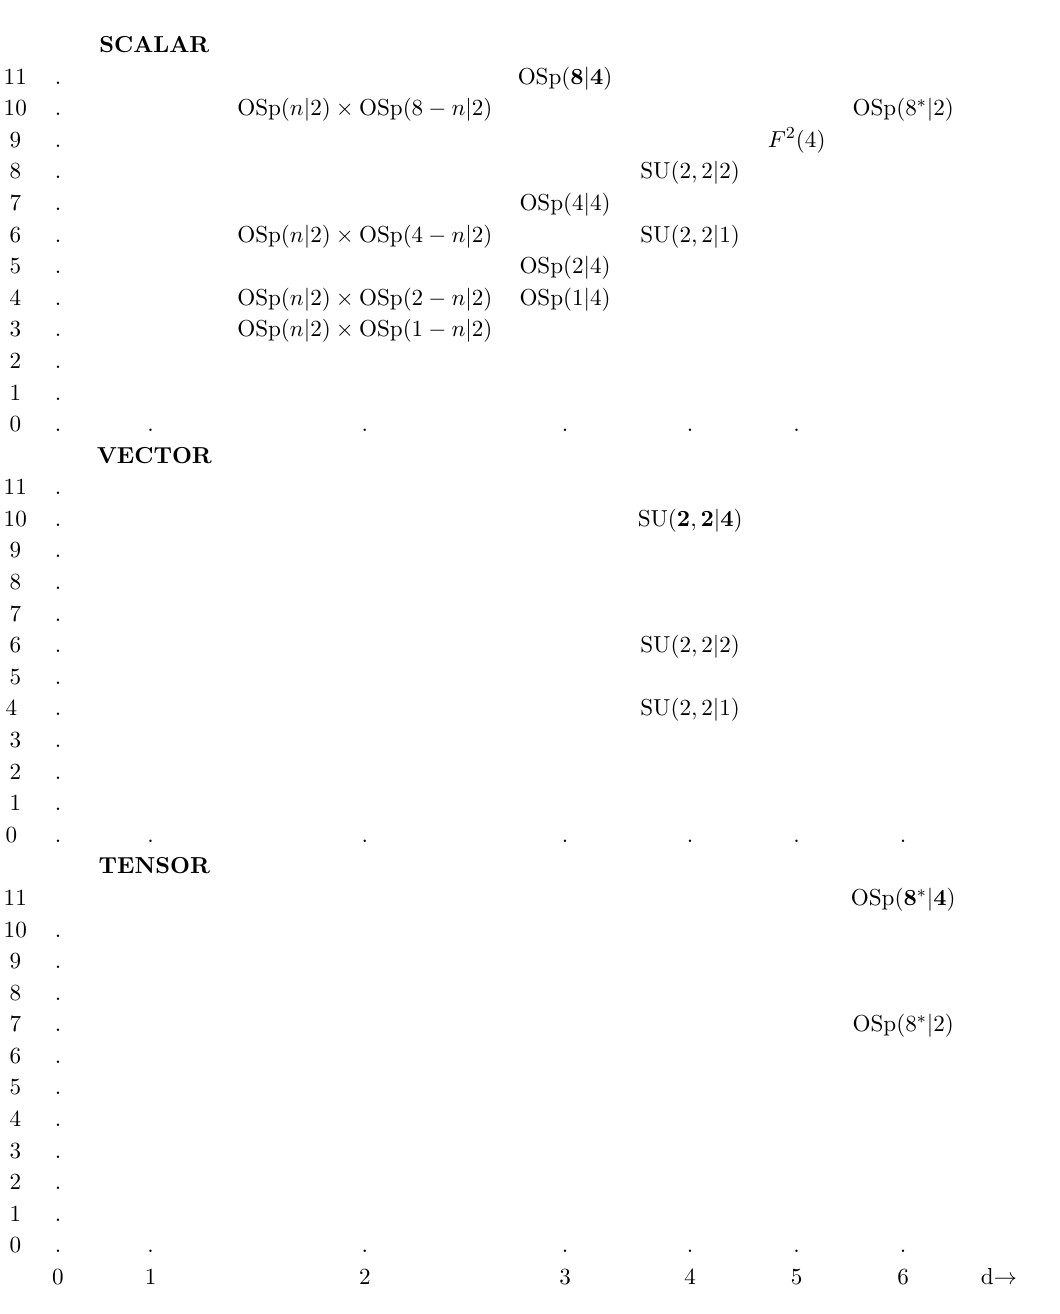
Table 3 . The brane-scans of superconformal groups: scalar supermultiplets: singletons ( p = 1 , 2 ), doubletons ( p = 3 , 4) and tripletons ( p = 5 ); vector supermultiplets: doubletons ( p = 3 ); tensor supermultiplets: tripletons ( p = 5 ). The M2-, D3- and M5-branes are in boldface.